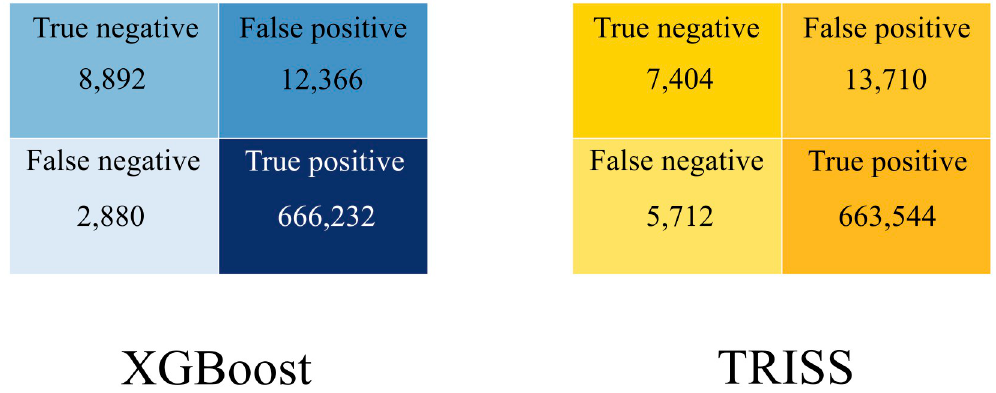
Fig 2. Confusion matrices of XGBoost and TRISS models demonstrating results from testing